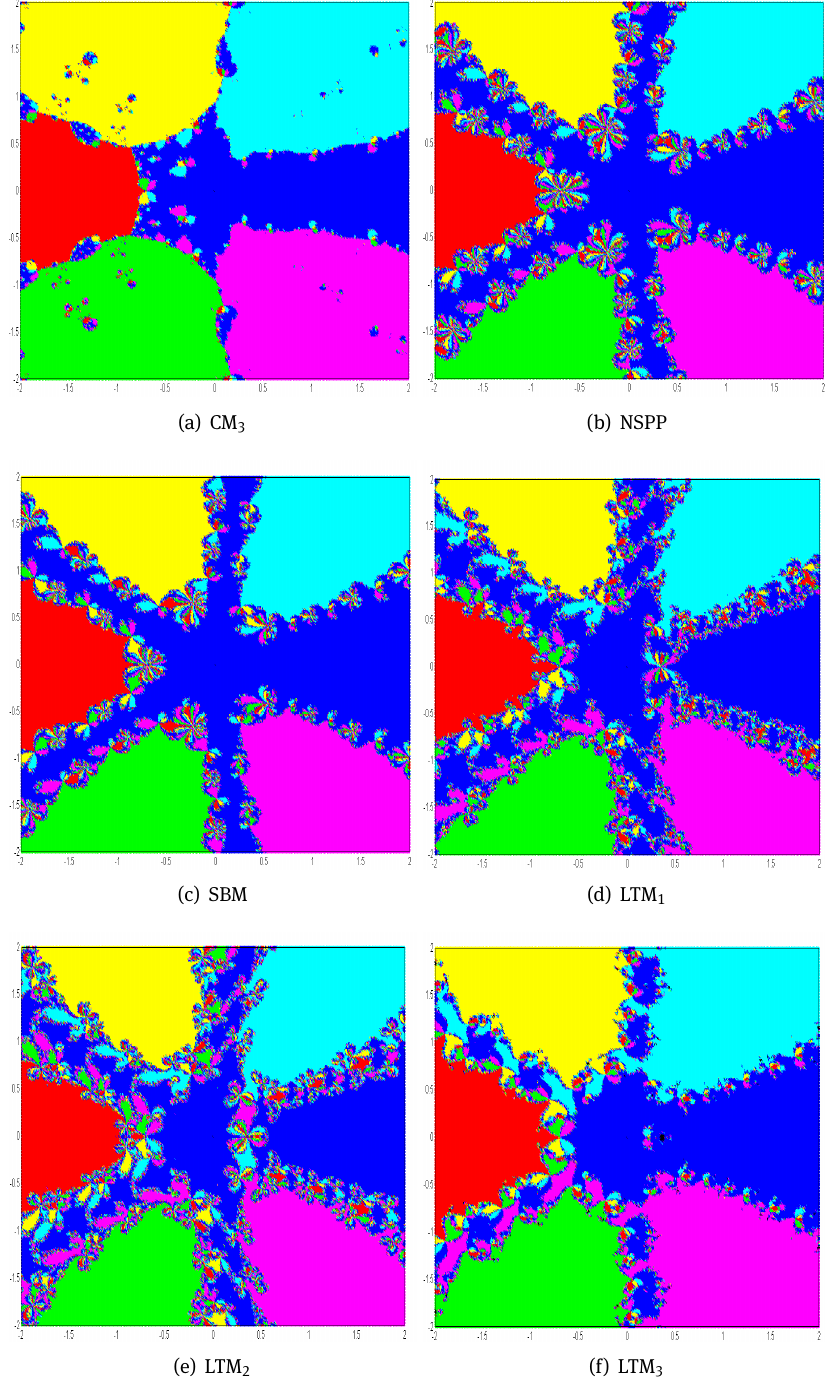
Figure 8: Basins of attraction of the methods CM 3 , NSPP, SBM, LTM 1 , LTM 2 and LTM 3 respectively for P 3 ( z ) = z 6 + z − 1